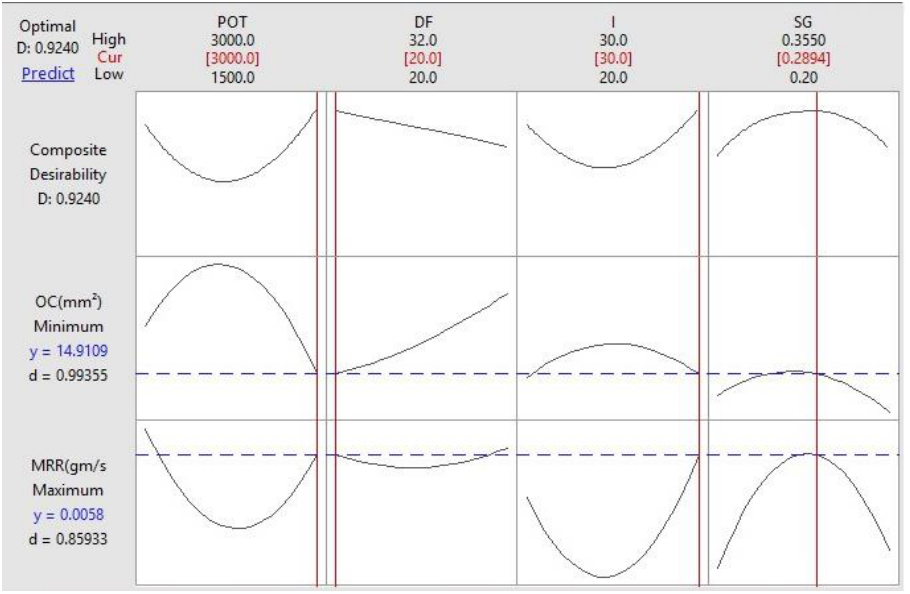
Fig. 12. Plot showing responses parameters versus process